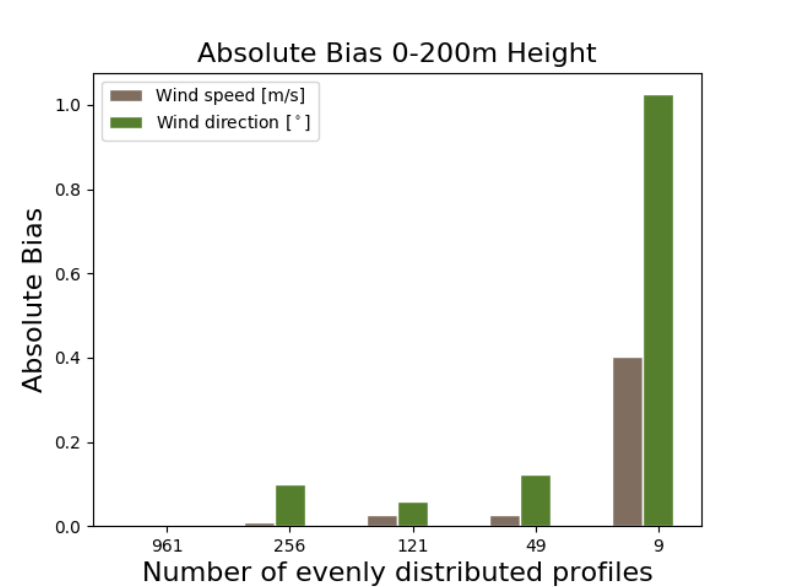
Figure 5. Different characteristic profiles in comparison: Average profiles of N evenly distributed profiles were extracted from the micro-scale simulations, and an absolute Bias was calculated, for both wind speed and wind direction (average between 0 and 200m, 5 m steps), compared to 961 profiles (3 km by 3 km with profiles every 100